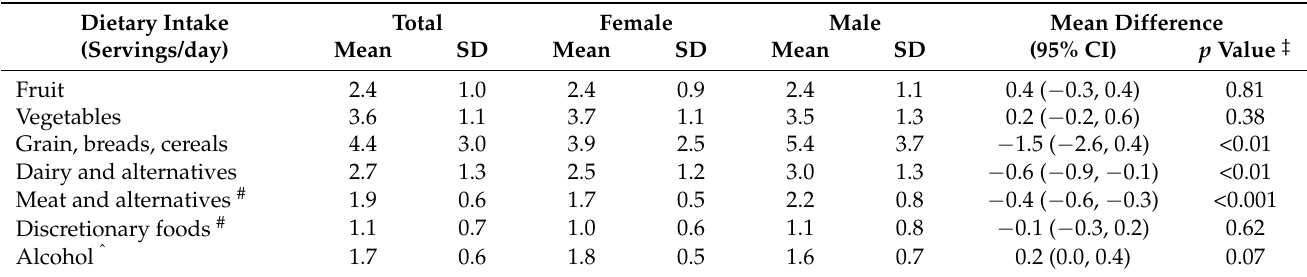
Table 5. Mean servings of core foods, discretionary foods, and alcohol reported by all athletes ( n = 165), and the difference in mean servings between female and male